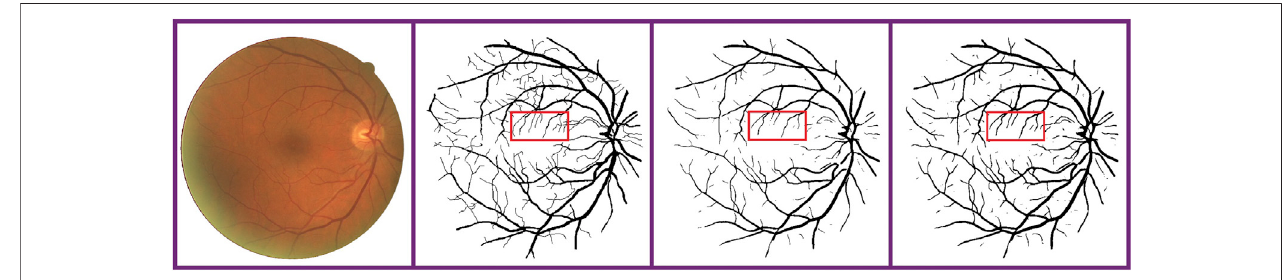
FIGURE 8 | Comparison of a normal FCN-based model and our proposed method on the FCN-based model. From the left to right: fundus retina image, ground truth, binary segmentation map of the normal FCN-based model and our proposed method on the FCN-based model. Obviously, our method can segment more thin blood vessels.